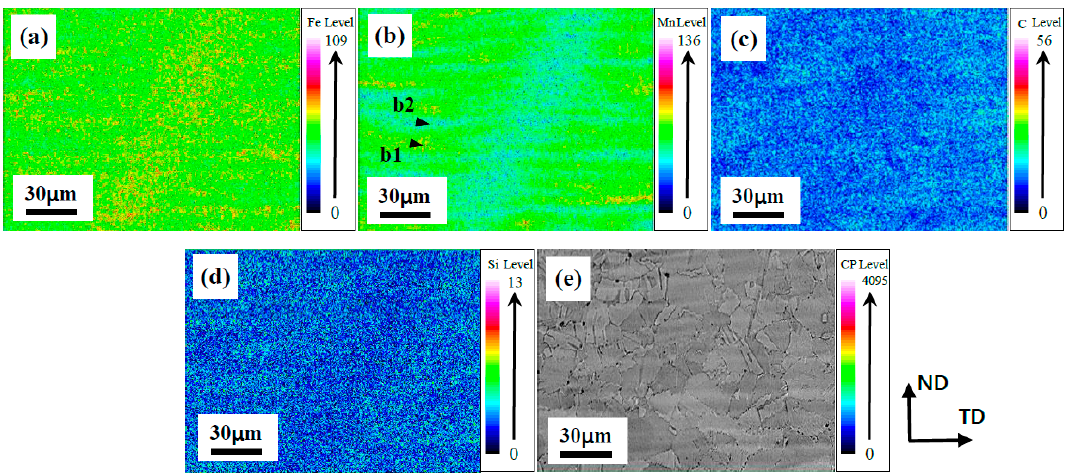
Figure 11. EMPA composition maps of ( a ) Fe, ( b ) Mn, ( c ) C, ( d ) Si elements and ( e ) EBSP in BM. The b1 and b2 arrows indicate the Mn segregation band and Mn depletion band, respectively.